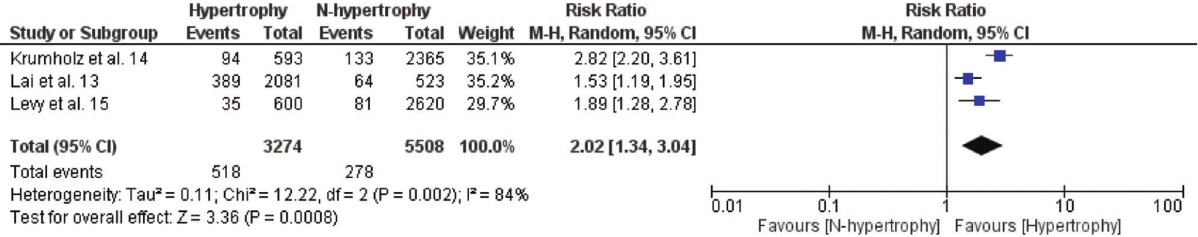
Figure 2.3 - The Risk Ratio and 95% confidence interval (CI) in the all-cause mortality, for Left Ventricular Hypertrophy group versus the Control